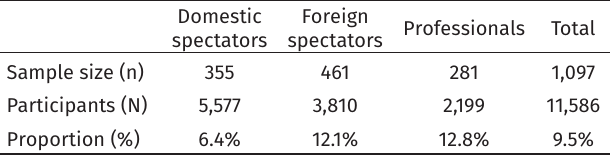
Table 1. Sample sizes and number of participants at Liebherr 2019 ITTF World Table Tennis Championships (Budapest,